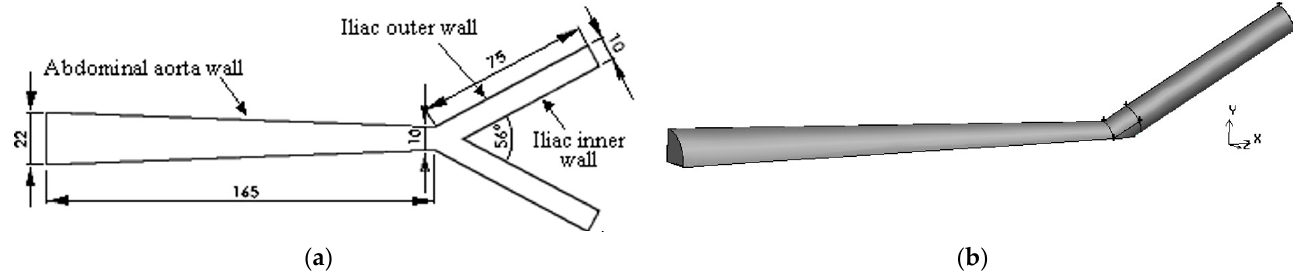
Figure 2. Geometry and dimensions (mm) of the aorta bifurcation into the iliac arteries, in the median z plane ( a ) and the three-dimensional model geometry view ( b ).